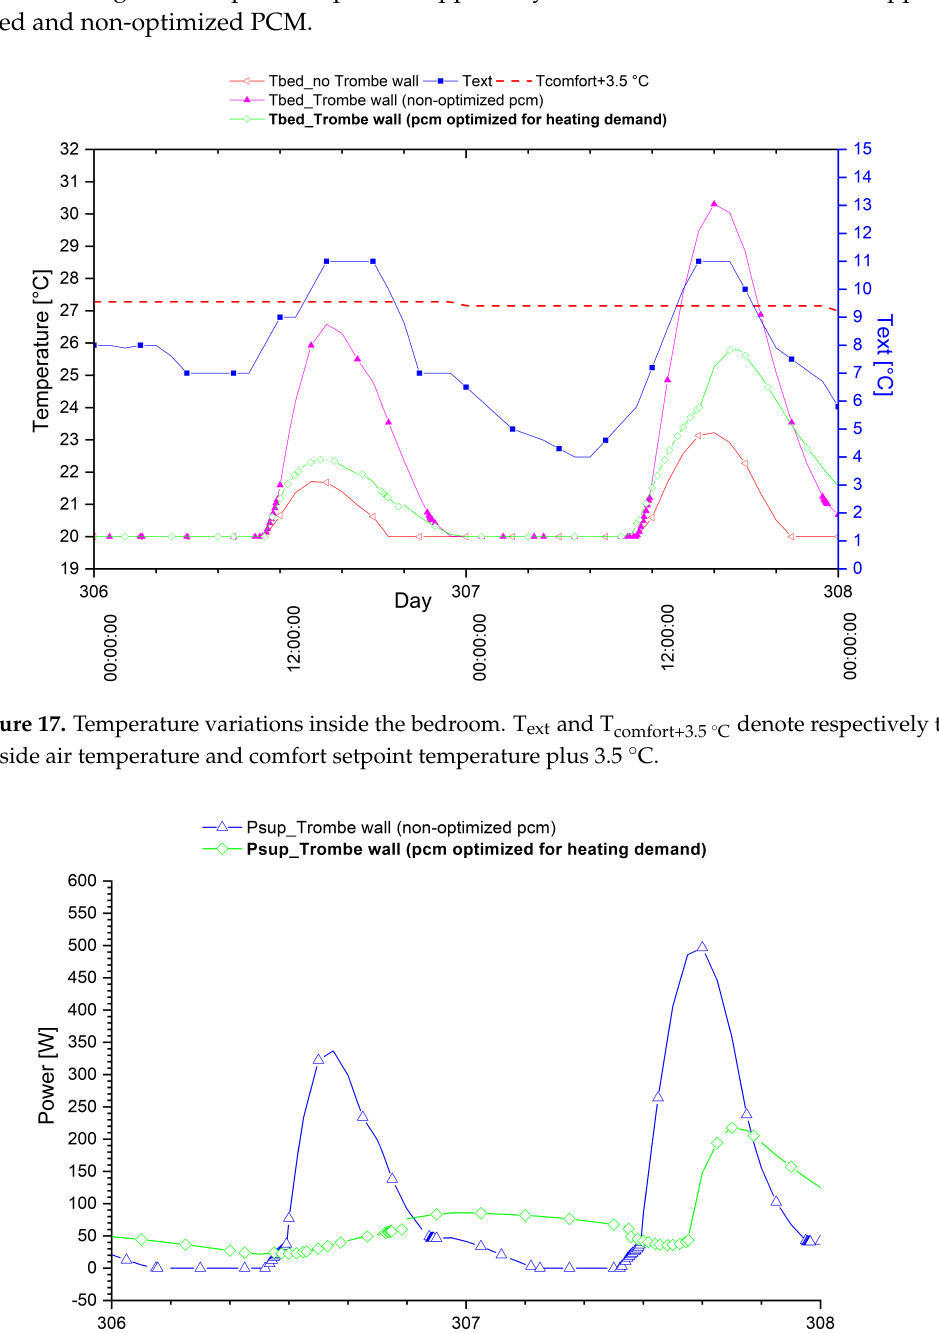
Figure 18. Comparison of the power supplied by the solar Trombe